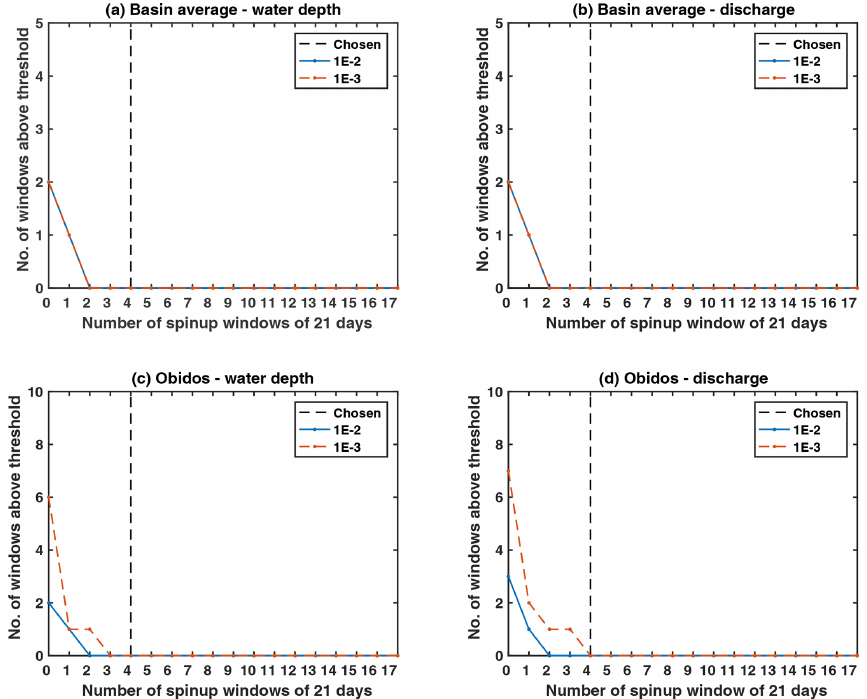
Figure 5. Results for the spinup sensitivity test. Each test run is represented along the x axis and referenced by its number of spinup windows. The y axis displays the number of windows during which the relative difference between the true run and the openloop run in which the Manning spatial distribution is modified is above the chosen threshold. These statistics are obtained for the discharge (a, c) and the water depth (b, d) and evaluated over the entire basin (a, b) and at the downstream station of Óbidos (c, d) . Note that the vertical dashed line corresponds to the minimum model spinup period retained in this study.